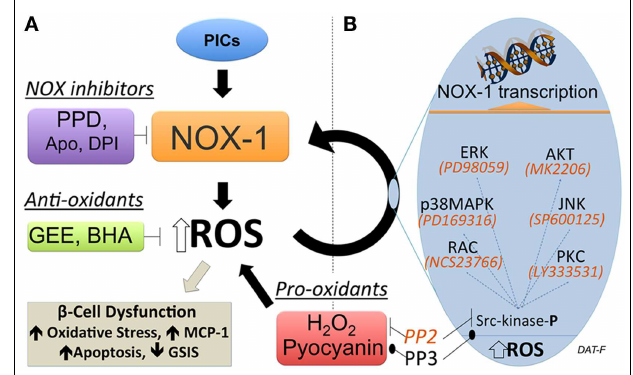
FIGURE 2 | Feed-forward regulation of NOX-1 expression in beta cells. (A) Experimental approach to demonstrate a feed-forward regulation of NOX-1 in beta cells that involves NOX activity and cellular redox state. Inhibition of NADPH oxidase activity (purple box) with either a selective NOX-1/4 pyrazolopyridine dione inhibitor (PPD) or general inhibitors apocynin (Apo), diphenylene iodonium (DPI) blocks NOX-1 gene and protein expression initiated by pro-inflammatory cytokine (PIC) stimulation.This suggests NADPH oxidase activity regulates NOX-1 expression. Neutralization of ROS with general anti-oxidants (green box) glutathione-ethyl ester (GEE) or butylated hydroxyanisole (BHA) inhibited PIC-stimulated NOX-1. Conversely, direct elevation of ROS with pro-oxidants (red box) hydrogen peroxide (H 2 O 2 ) or pyocyanin,